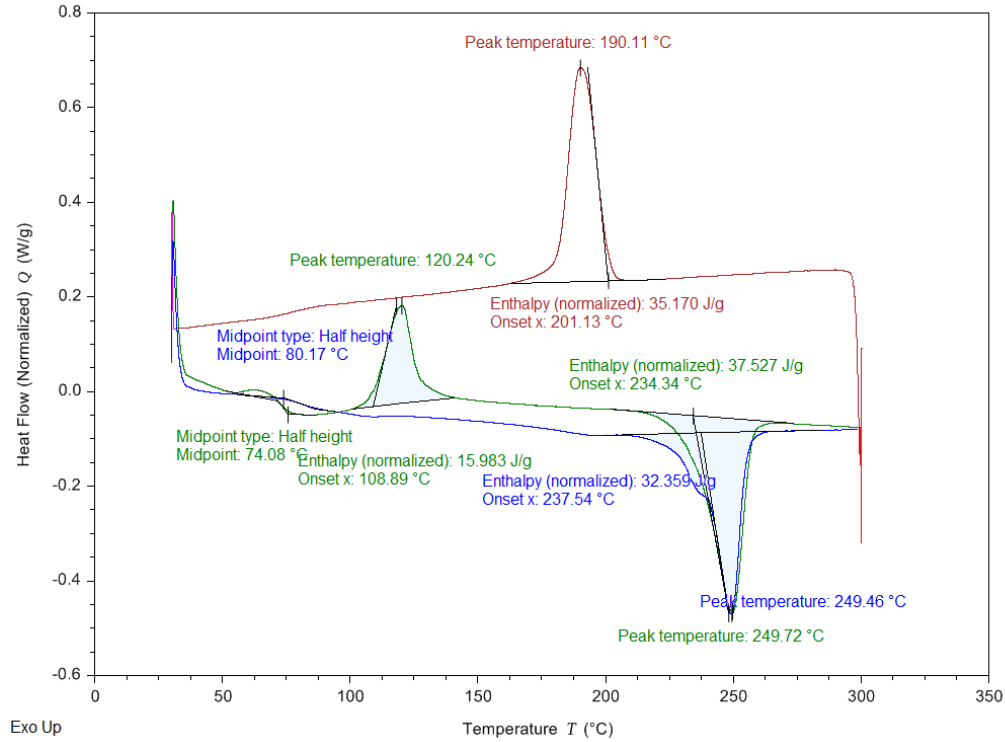
Figure 4. DSC scans of the printed specimen: first heating run (green curve), cooling run from the melt (red curve), and subsequent heating run (orange curve). The cooling and heating rates were 10 °C/min in all cases.